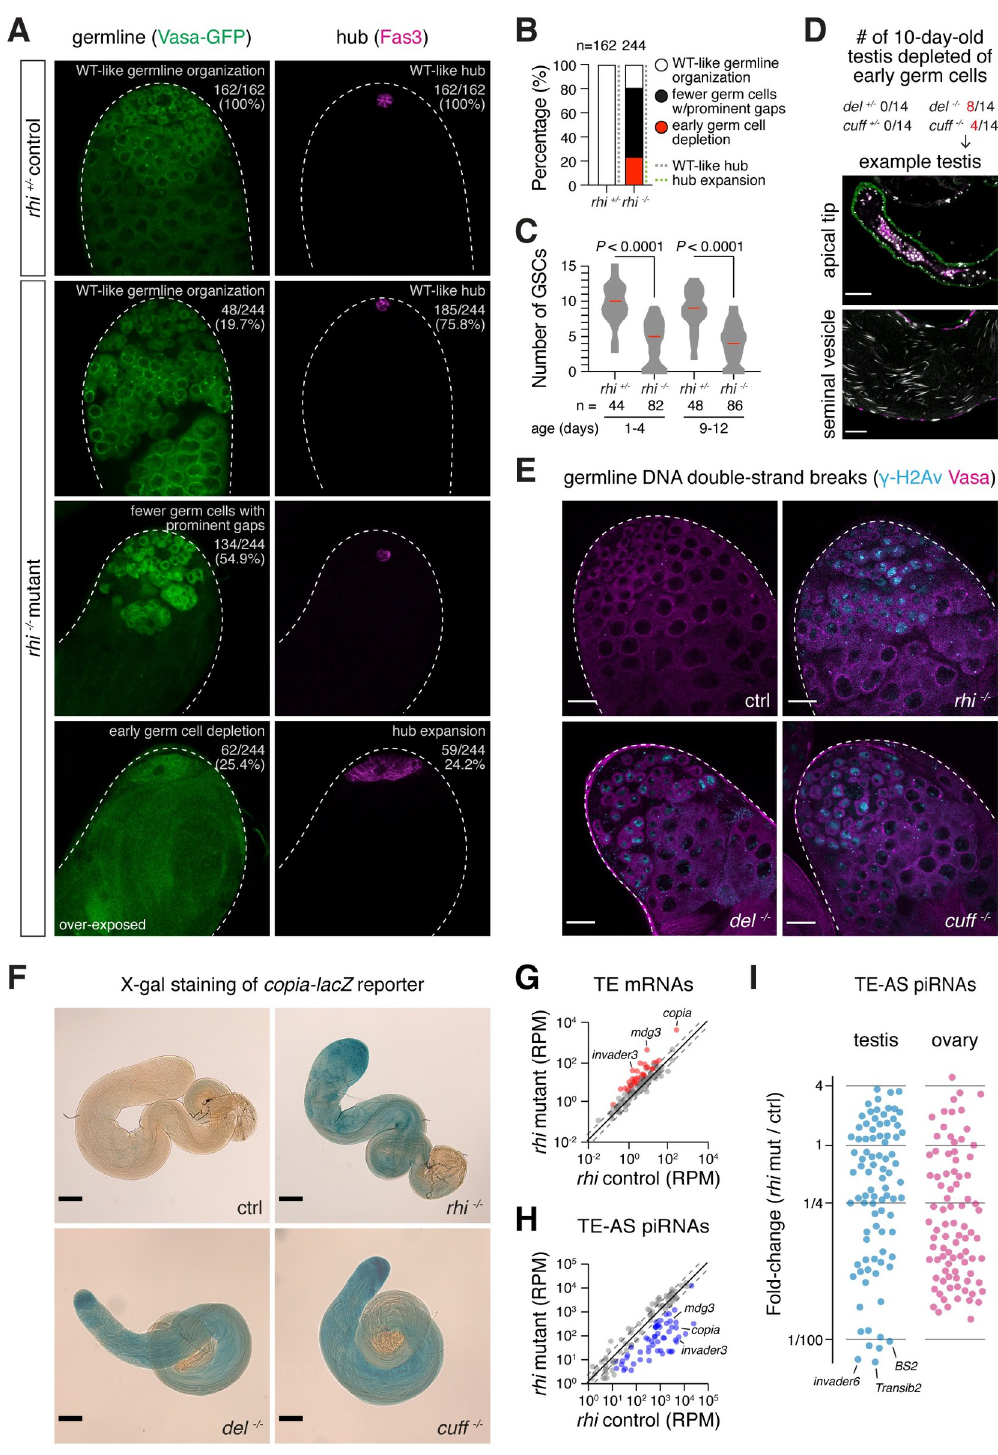
Fig 3. Loss of Rhi causes germ cell death, DNA damage and TE de-repression. (A) Loss of germ cells in testes of rhi mutants. Left: expression of germ cell marker, Vasa-GFP driven by vasa promoter, in testes of rhi 2/KG mutants and heterozygous control. Right: somatic hub cells that form a niche for GSCs are marked with Fas3. Classification of germ cell phenotype (defined by number and organization of germ cells that express Vasa) and hub size phenotype (defined by cells that express Fas3) are labeled at the top right with corresponding statistics. All images on the same scale as (D). (B)